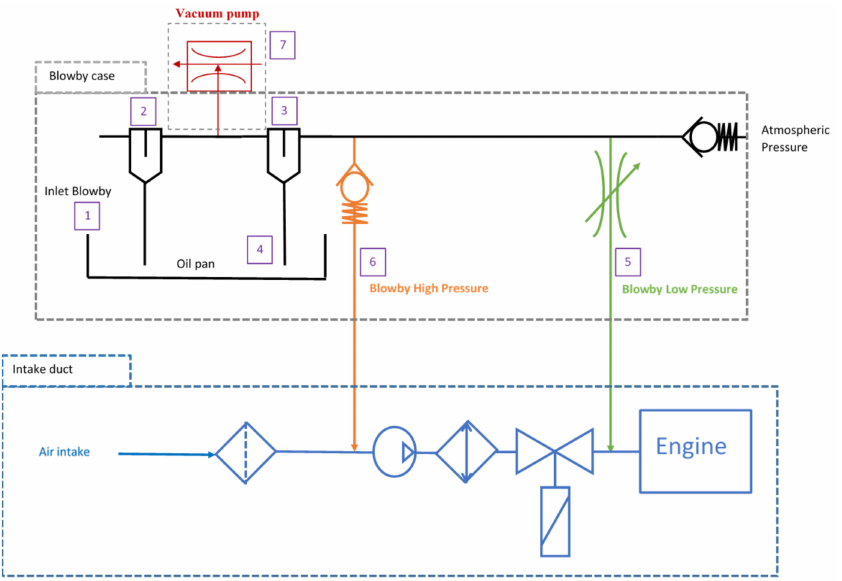
Figure 5. Simplified diagram of an engine oil